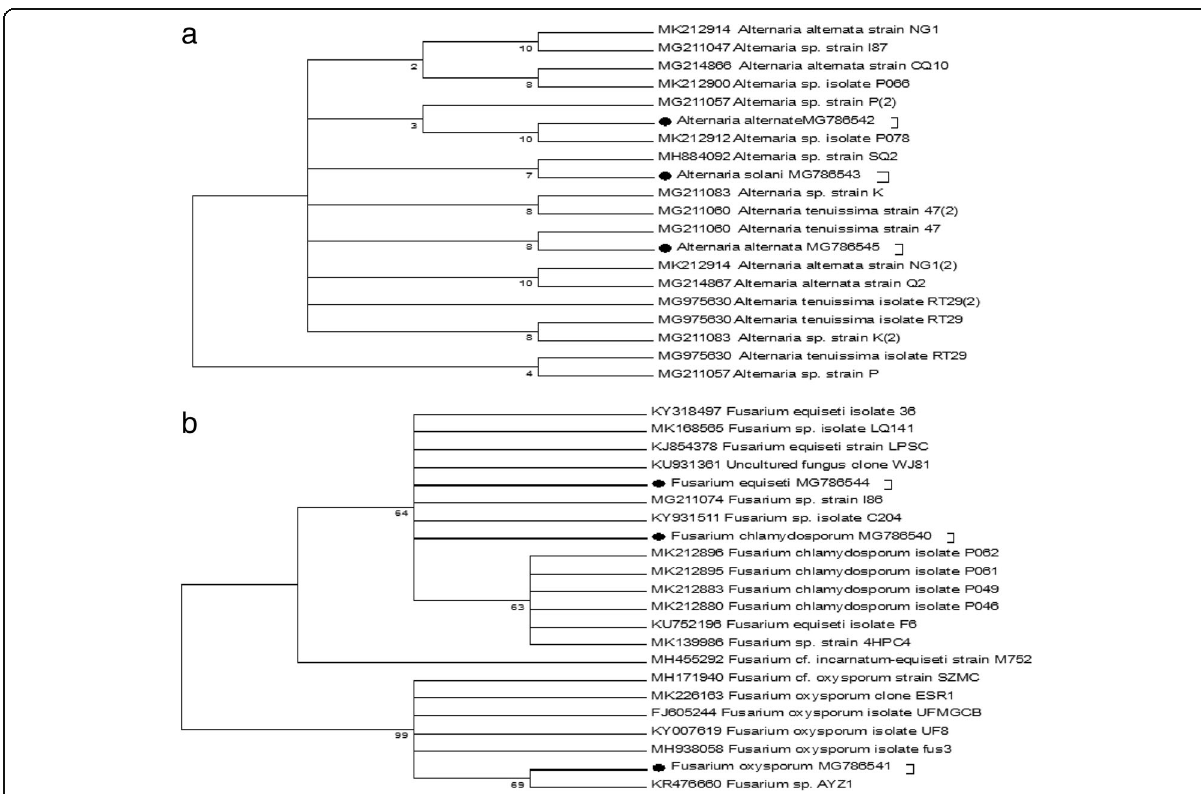
Fig. 2 Phylogenetic tree based on the alignment of nucleotide sequences of ITS region of rDNA gene among selected endophytic fungal isolates ( a ) Alternaria sp, ( b ) Fusarium sp isolated from the leaves of both Chenopodium album and Pelargonium graveolens and roots of Malva parviflora